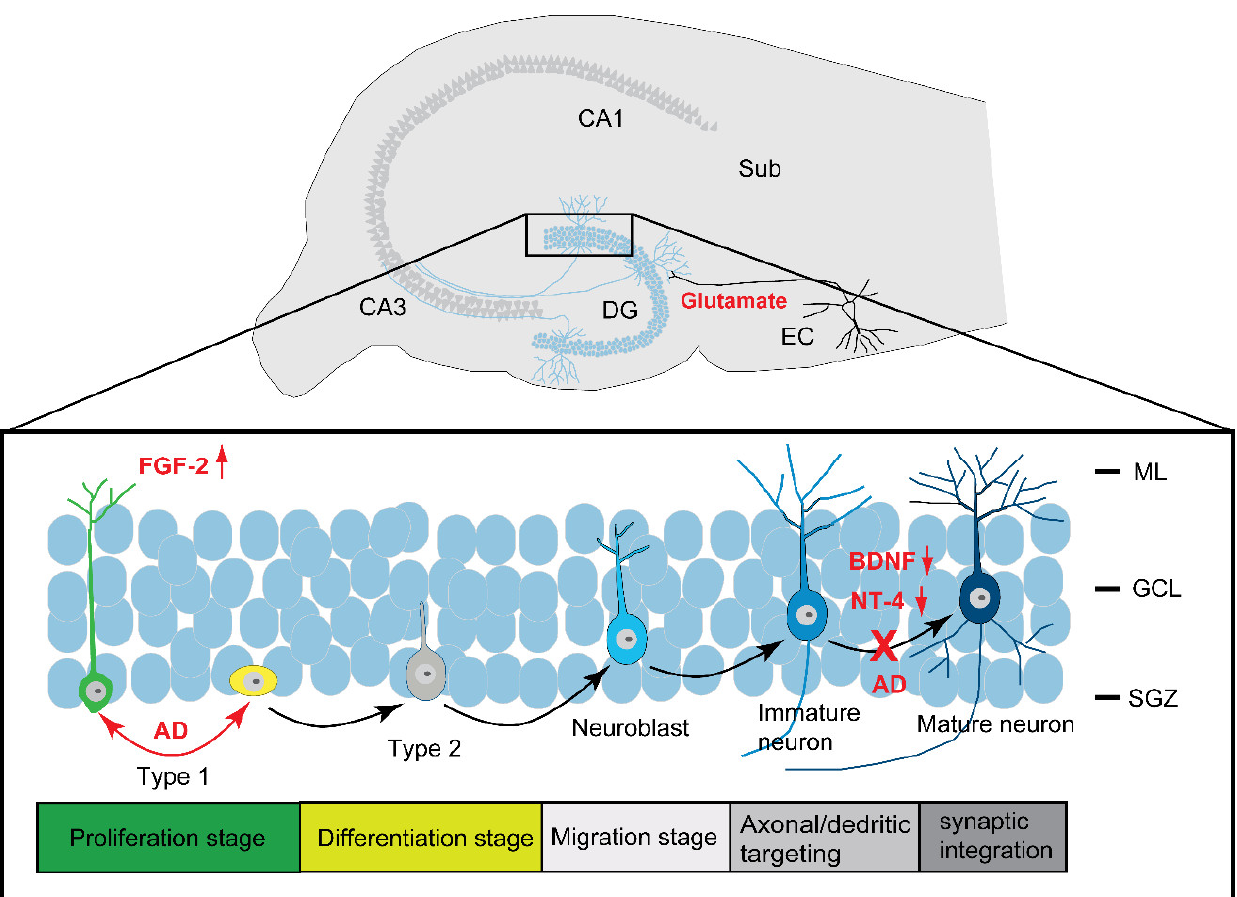
Figure 1. Neurogenesis in AD. The proliferative stage, or stage 1, is characterized by the formation of type 1 radial glial-like cells that express glial fibrillary acidic protein (GFAP), nestin, and sex-determining region Y-box 2 (Sox2). The differentiation stage, or stage 2, is characterized by the presence of intermediate progenitor cells (type 2 cells) that express doublecortin (DCX) or polysialylated neural cell adhesion molecules (PSA-NCAM). During the migration stage, or stage 3, the type 2 cells give rise to the type 3 cells or neuroblasts also called neuronal lineage committed cells that express DCX, PSA-NCAM, and markers for immature neurons (Tuj-1b or NeuroD). The axonal and dendritic targeting or stage 4 and the synaptic integration or stage 5 are characterized by the presence of mature neurons that express calbindin. The Alzheimer’s pathology-associated proteins such as hyperphosphorylated tau, PSEN 1, 2 mutations, A β , the APOE4 isoforms and the tau kinase GSK3 β are known to affect the process of neurogenesis in AD at different stages. The imbalance of growth factors is also an essential cause of a defective neurogenesis in